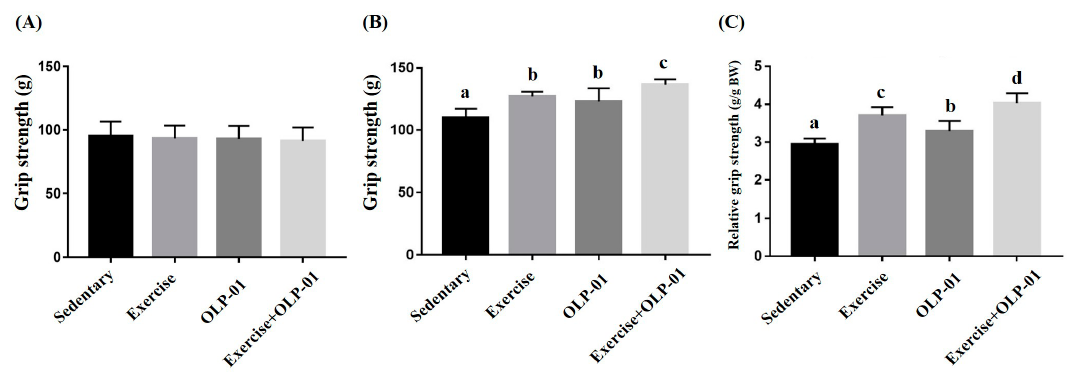
Figure 4. Effects of six weeks of exercise and probiotic interventions on baseline grip strength ( A ), after administration ( B ), and relative strength ( C ). Data are represented as mean ± SD and the columns with different letters (a, b, c, d) were significantly different at p < 0.05.